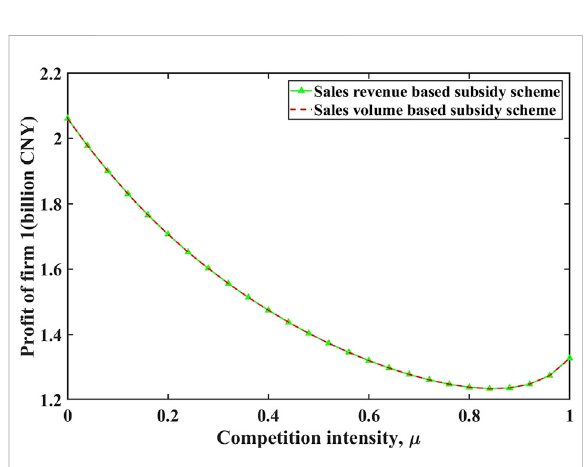
FIGURE 6 Comparisonof fi rm1 ’ spro fi tundertwodifferentsubsidyschemes.